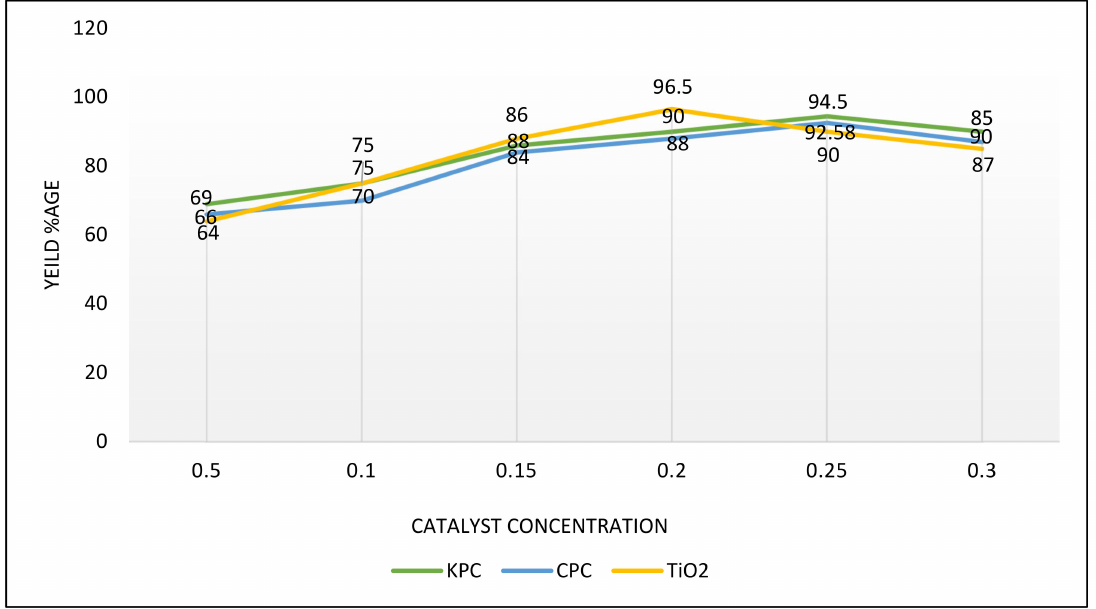
Figure 25. Level of catalyst effect on transesterification, while other variables were kept constant (temperature, time period, oil-to-methanol